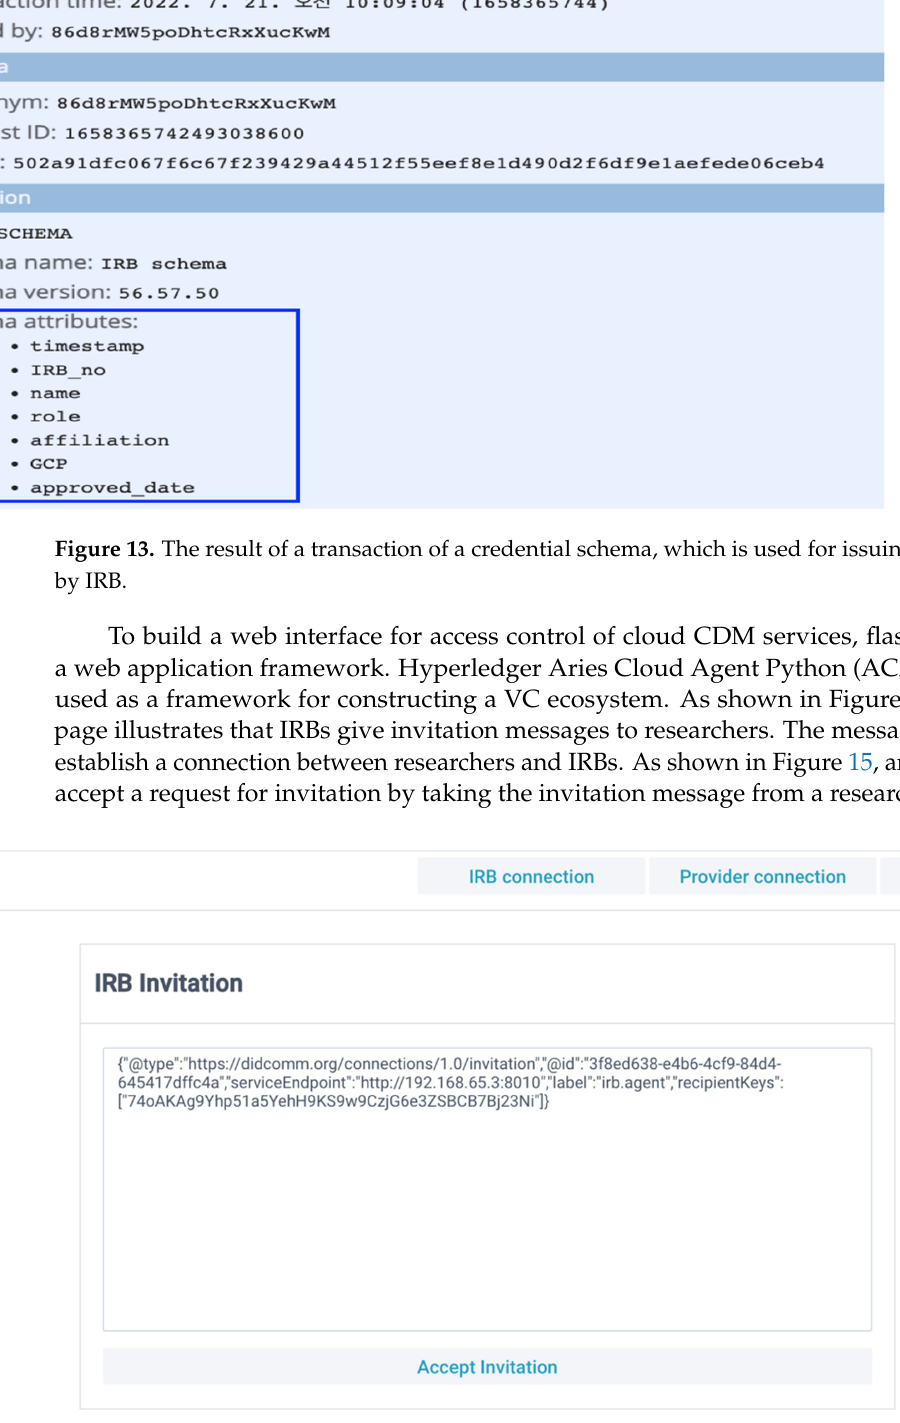
Figure 14. The invitation message which is generated by IRB.